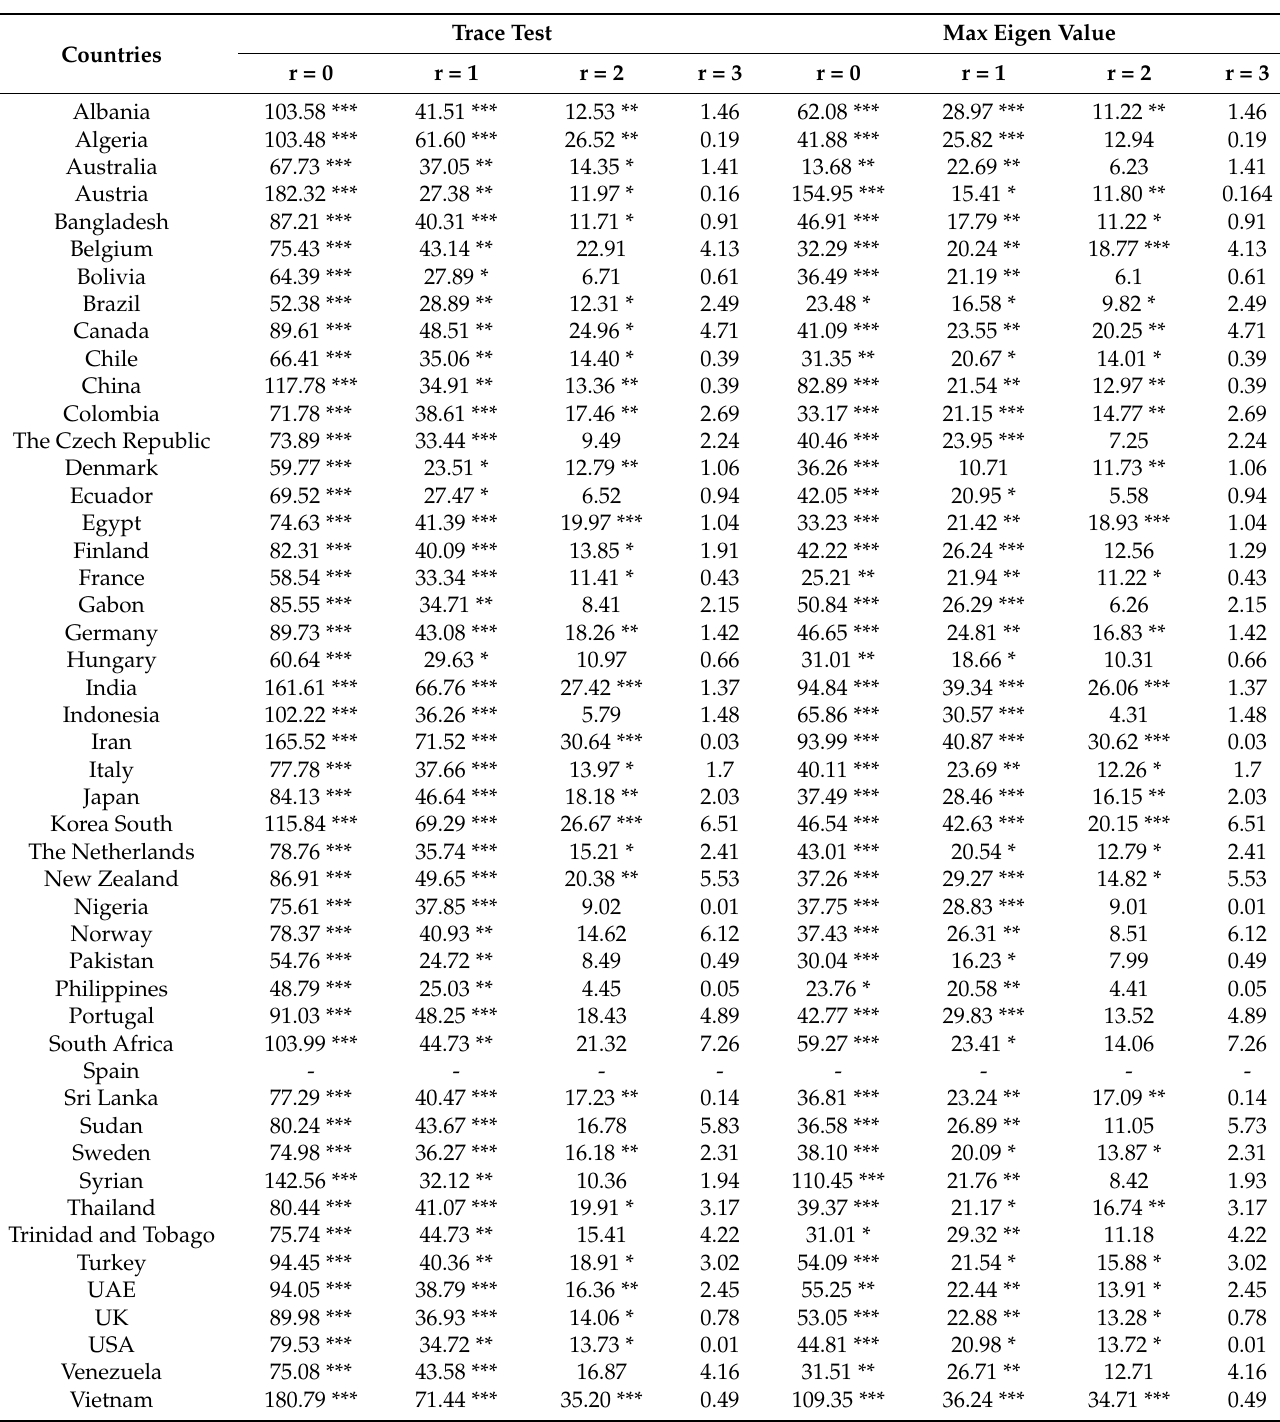
Table A5. Cointegration